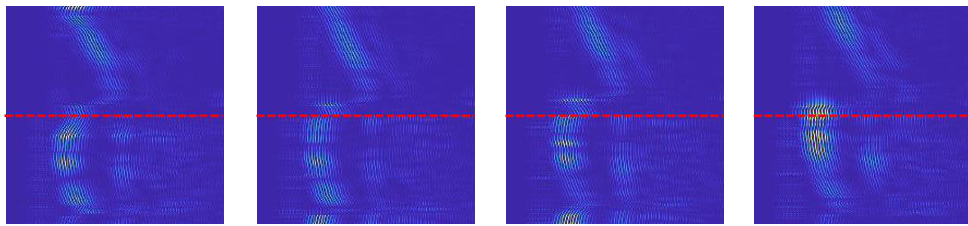
Figure 15. Inter-sample pattern analysis: Pattern of images for four different samples of the same gesture (LR-swipe).